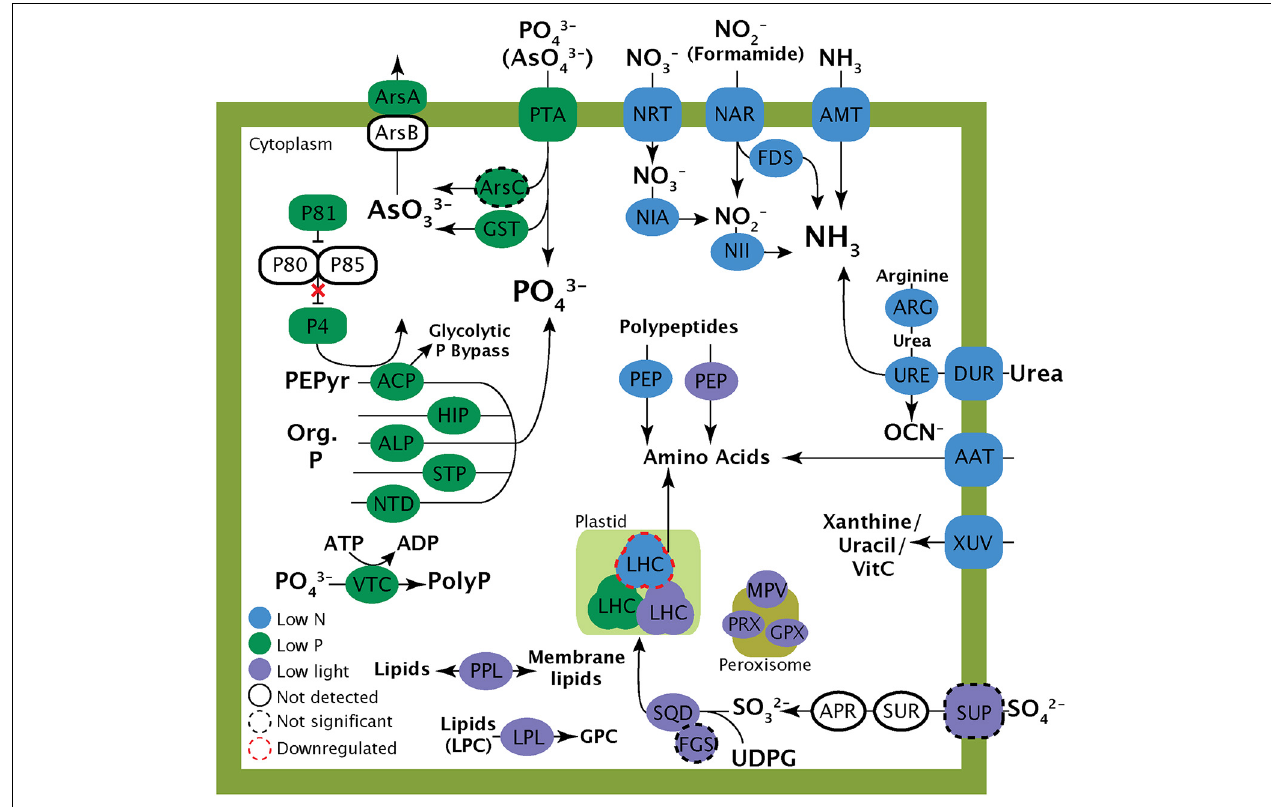
FIGURE 4 | Schematic cell model illustrating the potential role of the transcripts highlighted in this study. Localization of the proteins depicted is for clarity and is not meant to represent actual protein localization in the cell. Proteins with black dashed lines represent transcripts that were detected in transcriptomes but were not significantly differentially expressed relative to the control. AAP, Amino acid permease; ACP, Acid phosphatase; ALP, Alkaline phosphatase; AMT, Ammonia transporter; APR, Adenosine-5 (cid:4) -phosphosulfate reductase, ARG, arginase; ArsA, Arsenite trasnlocating ATPase; ArsB, Arsenite efflux protein; ArsC, Arsenate reductase; DUR, Urea transporter; FDS,